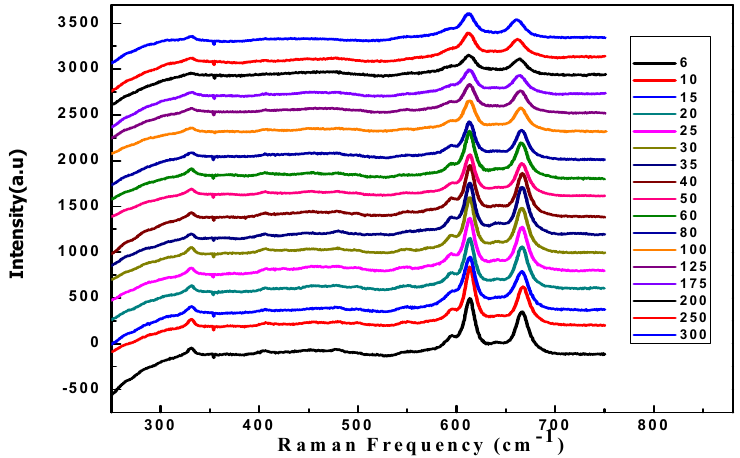
Figure 4. Raman spectra of BiMn 2 O 5 for different temperatures.